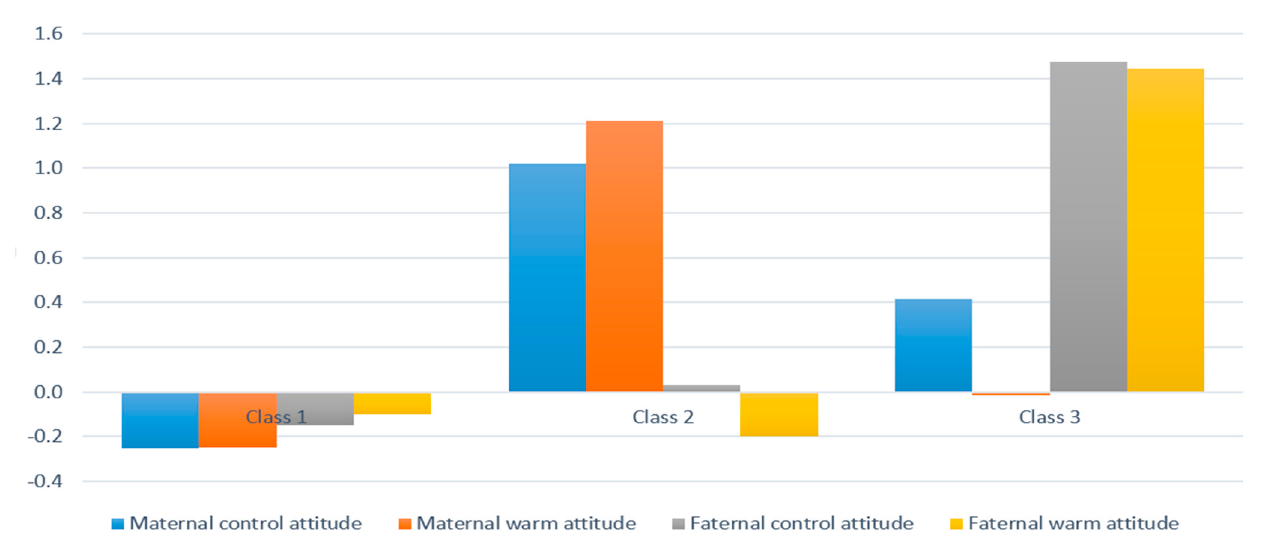
Figure 2. Latent class of child-rearing attitude (8th wave). Figure 1. Latent class of child-rearing attitude (5th wave). Table 3. Model fit of latent profile analysis of child-rearing attitude (8th wave).